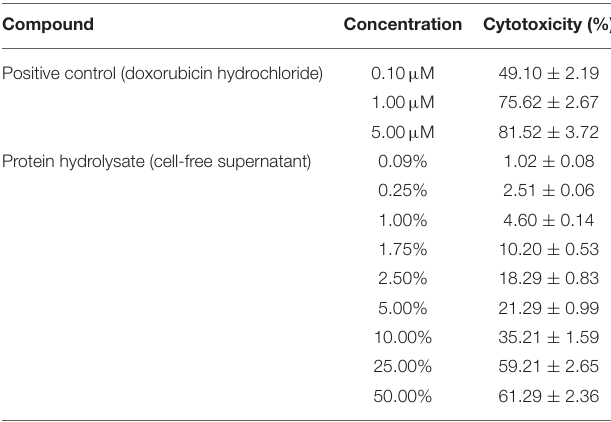
TABLE 4 | Cytotoxicity evaluation of protein hydrolysate (0.09 − 50%) using MTT assay in HepG2 cells. Compound Concentration Cytotoxicity (%) Positive control (doxorubicin hydrochloride)